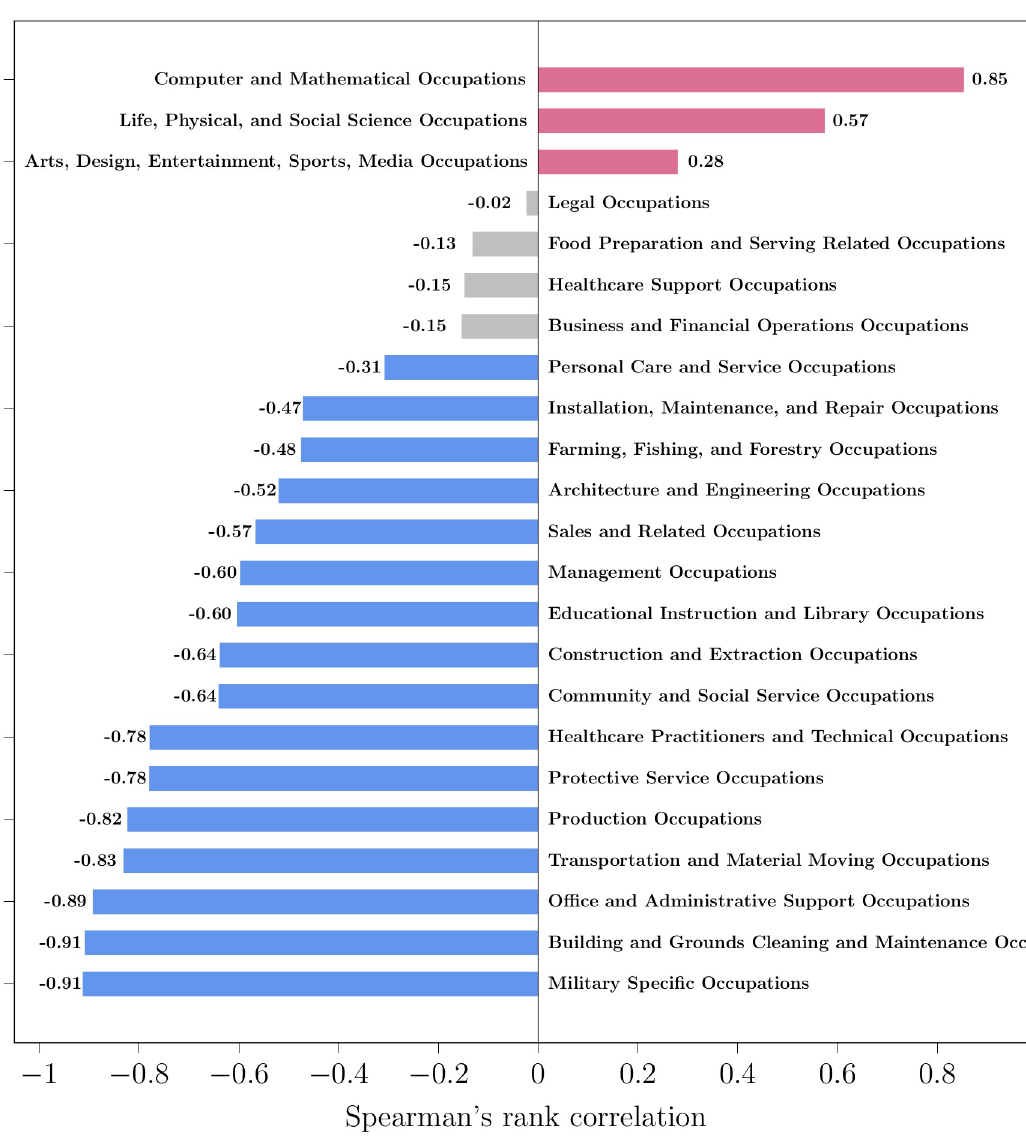
Fig 6. Spearman’s rank correlation coefficient of the media frequency of SOC groups vs time. The red-colored bars have positive correlation (increasing trend), and the blue-colored bars have negative correlation (decreasing trend). The grey-colored bars mean that the correlation is not statistically significant ( α =